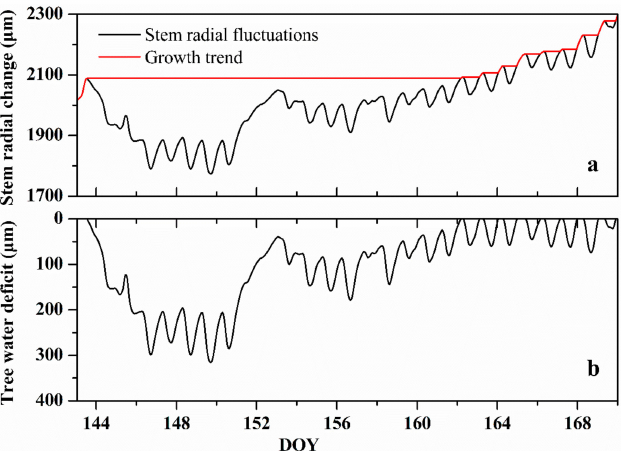
Figure 1. Example of tree water deficit calculation, showing the stem radial fluctuations (black line) and the growth trend according to the zero growth concept (red line) ( a ), tree water deficit, as the difference between the growth trend and stem radial fluctuations ( b ). Examples of data recorded in one tree between day of year (DOY) 144 to 170.